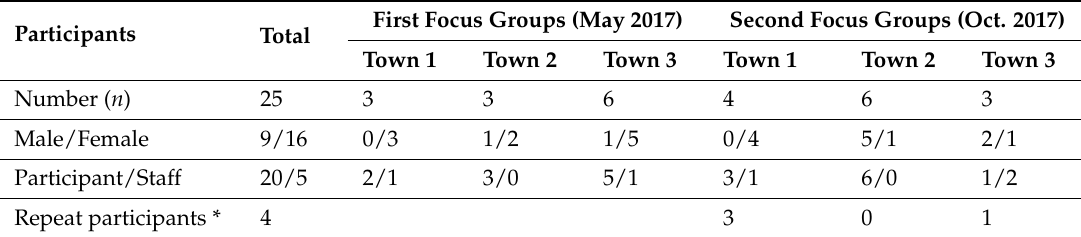
Table 1. Focus group discussions and